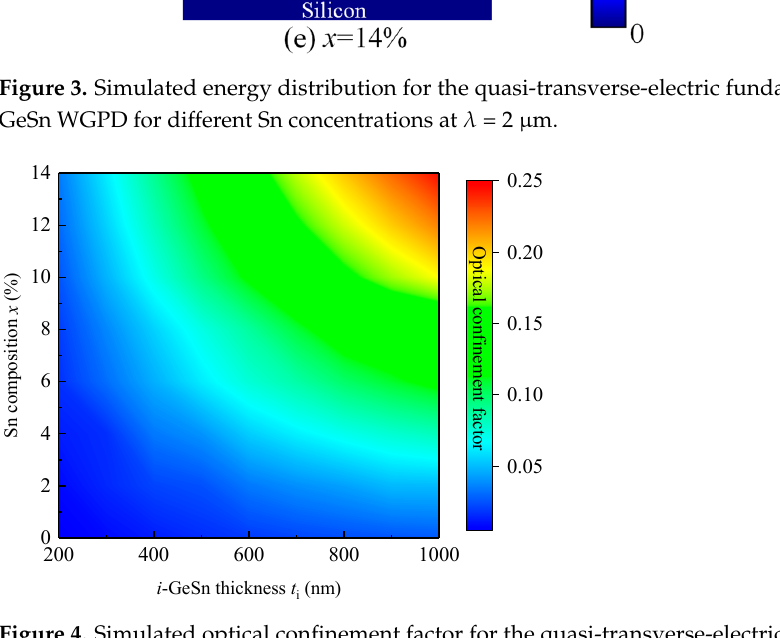
Figure 4. Simulated optical confinement factor for the quasi-transverse-electric fundamental mode for the GeSn active layer as a function of thickness and Sn concentration of the GeSn WGPD at λ = 2 µm.